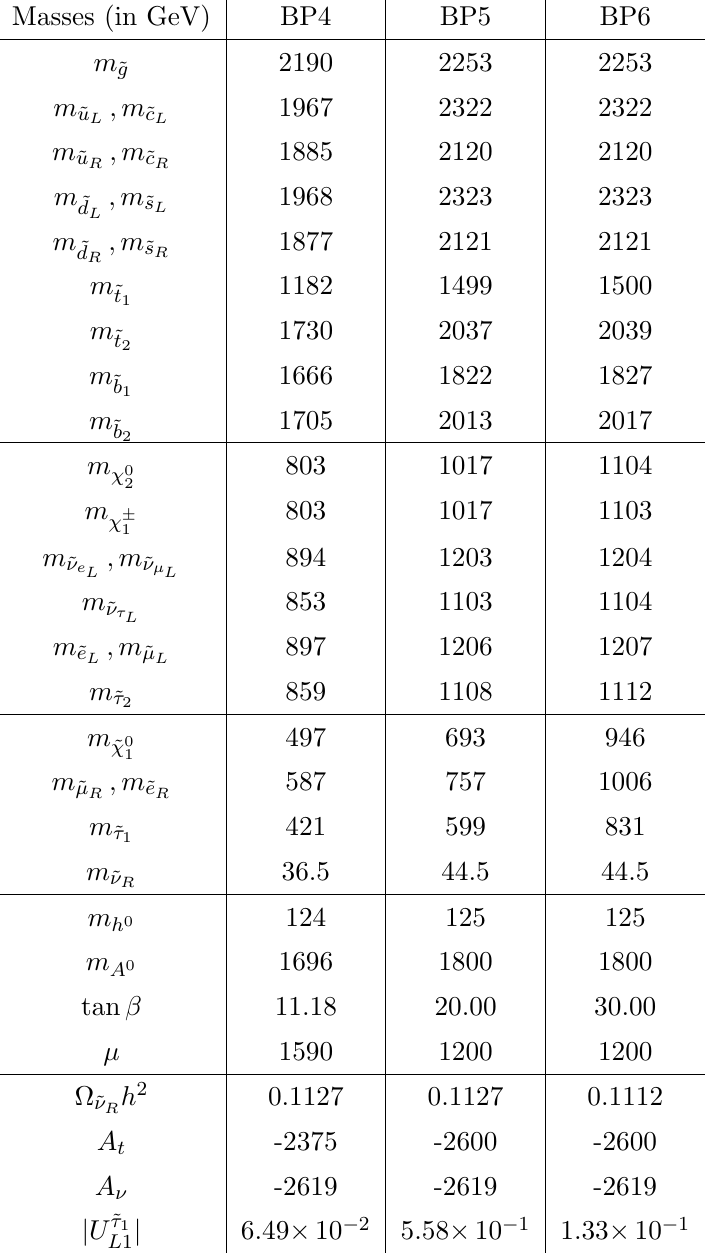
Table 3 . Benchmark points for studying the m